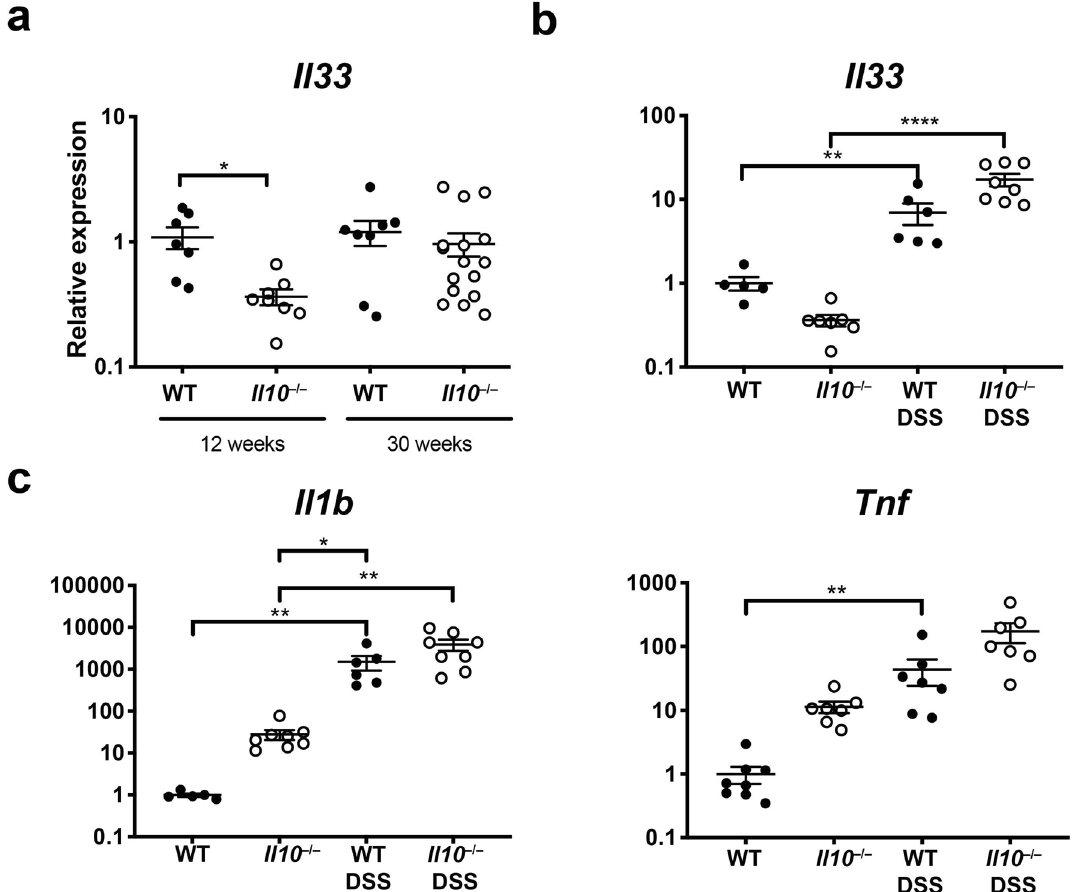
Figure 2. IL-33 was induced in acute DSS colitis but not chronic Il10 −/− colitis. Il33 expression assessed by real- time RT-PCR in the distal colon of ( A ) 12-week- and 30-week-old mice WT and Il10 −/− mice or ( B ) 12-week old WT and Il10 −/− mice treated with DSS for 5 days and harvested on day 7. ( C ) Il1b and Tnf expression in Il10 −/− and WT mice with or without DSS treatment. N = 5–8/group **p < 0.01, ****p < Il33 is induced in DSS colitis but not Il10 −/− colitis. To better understand the lack of an effect of Il33 deficiency on colitis in Il10 −/− mice, we examined colon Il33 expression in WT and Il10 −/− mice at 12 and 30 weeks of age. Il33 was not increased in Il10 −/− mice with chronic colitis compared to WT mice (Fig. 2A). Oth- ers have demonstrated a protective role for IL-33 in DSS-induced colitis 19,24,25 . In contrast to the chronic Il10 - deficient model, we observed a sevenfold increase in colon Il33 expression in acute colitis induced by epithelial injury from DSS compared to untreated WT mice (Fig. 2B), indicating that factors specific to DSS colitis may be regulating IL-33. To determine whether IL-10 is required for induction of IL-33 during colitis, we exposed Il10 −/− mice to DSS. DSS exposure induced colon Il33 expression significantly compared to untreated mice (Fig. 2B), suggesting that IL-10 is not required for Il33 induction during colitis. To begin to understand what difference might be leading to differences in regulation of IL-33 in the two models of murine colitis, we examined tissue RNA expression for two cytokines that have previously been shown to induce IL-33, TNF and IL1-β 16 . Colon Tnf expression was 4.6 fold higher, and, strikingly, Il1b expression was 1419-fold higher in DSS-treated WT mice compared to 12-week old IL-10KO mice with colitis (Fig. 2C). Colon fibroblasts are the main source of Il33 . IL-33 citrine reporter mice ( Il33 Cit /+ ) were used to inves- tigate the cellular source of IL-33 in unchallenged WT mice. This reporter uses citrine fluorescence as a surro- gate for IL-33 mRNA expression with the GFP-derived Citrine gene inserted directly downstream of the ATG start codon of Il33 14 . Immunofluorescence microscopy colocalized citrine expression in the proximal colon with alpha smooth muscle actin (α-SMA) and vimentin in unchallenged Il33 Cit /+ mice, suggesting IL-33 is expressed by colon myofibroblasts (Fig. 3A,B). To confirm this, flow cytometry was performed for epithelial, hematopoi- etic and fibroblast markers on the lamina propria fraction. In the lamina propria, citrine + cells were EpCam − , CD45 − , and > 85% vimentin + , consistent with fibroblasts (Fig. 3C). Fibroblasts are a complex population of many different subsets. As single cell studies have demonstrated, stromal cells can be subdivided into as many as six subsets 26 . To further phenotype these cells, we also examined expression of CD90, CD140a and CD49a (Fig. 3D). CD90 is reported to be expressed on fibroblasts located in close proximity to stem cells and support organoid growth in vitro 27 . CD49a is α1 integrin and is involved in